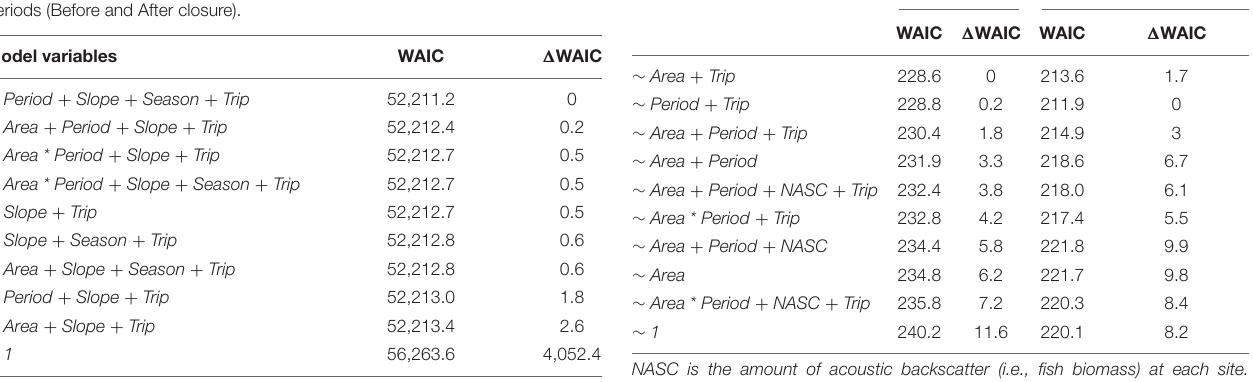
TABLE 2 | Candidate models examined for their fit to the data consisting of catch-per-unit-effort (CPUE) for all species and assessed species only at each site sampled with hook-and-line in both areas (Snowy Wreck Marine Protected Area or Control) and periods (Before and After). Model